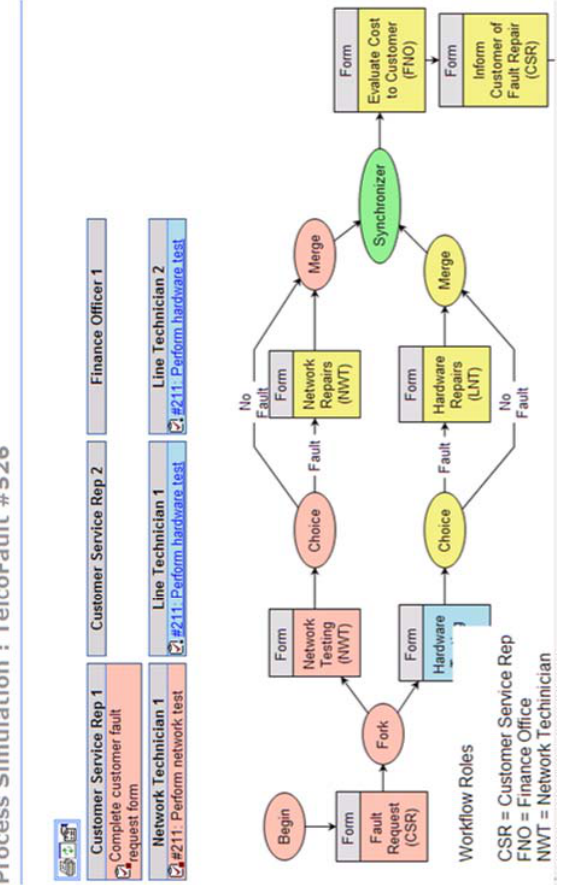
Fig. 7. Color Coding in a Display of a Workflow Process Instance 34